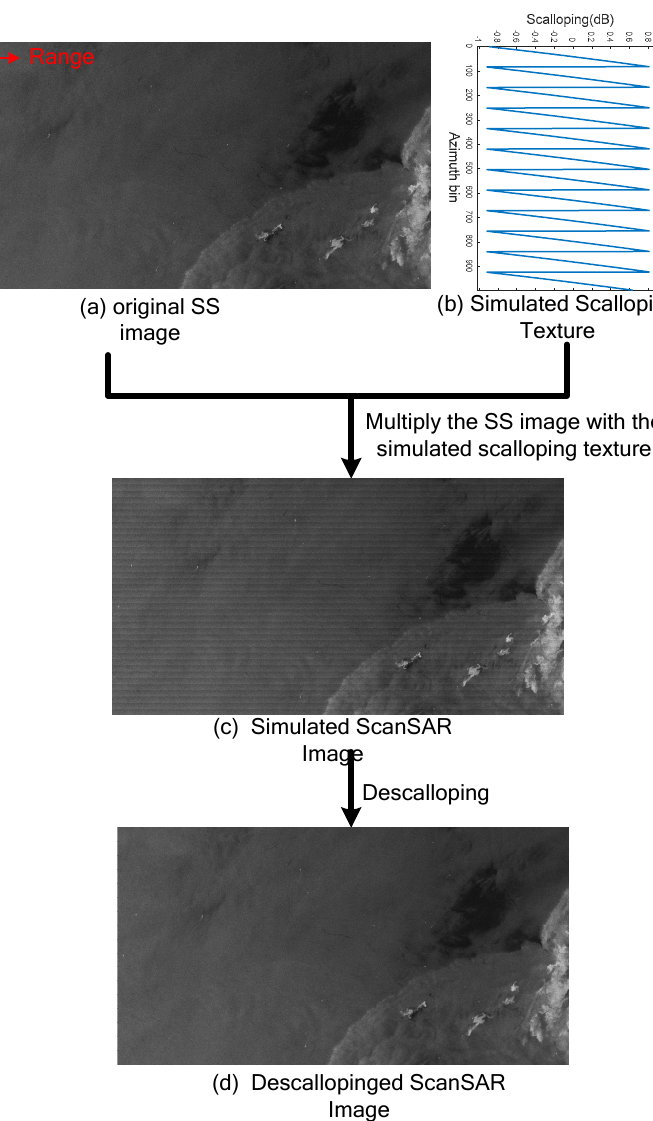
Figure 11. ScanSAR image simulation schematic diagram.